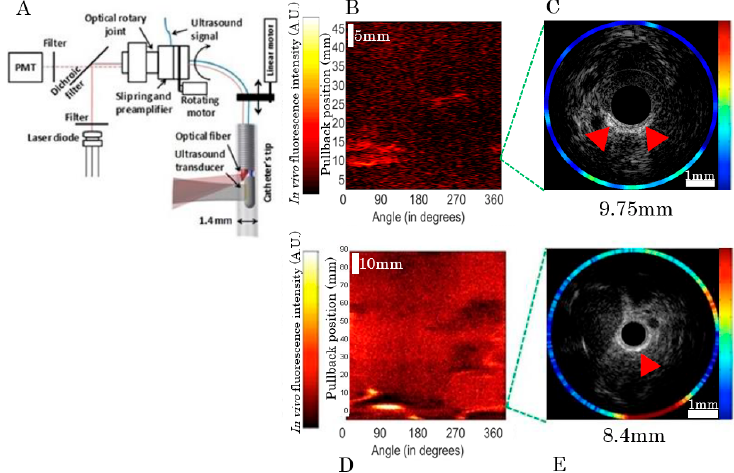
Figure 2. In vivo imaging system and typical images. ( A ) Overview of the bimodal catheter system with a detailed view of the catheter’s tip. PMT stands for photomultiplier tube; ( B ) Paired in vivo near-infrared fluorescence signal detected over 360 degrees with 50 mm pullback length; and ( C ) integrated NIRF-IVUS cross-sectional imaging with partial fluorescence signal and echolucent plaque colocalization (shown by red arrows) in model 1. Atherosclerotic plaque, shown by echolucent signal on IVUS ( D , E ), was partly correlated with indocyanine green (ICG)-fluorescence signal at 8.4 mm of pullback (red arrow) in model 2.